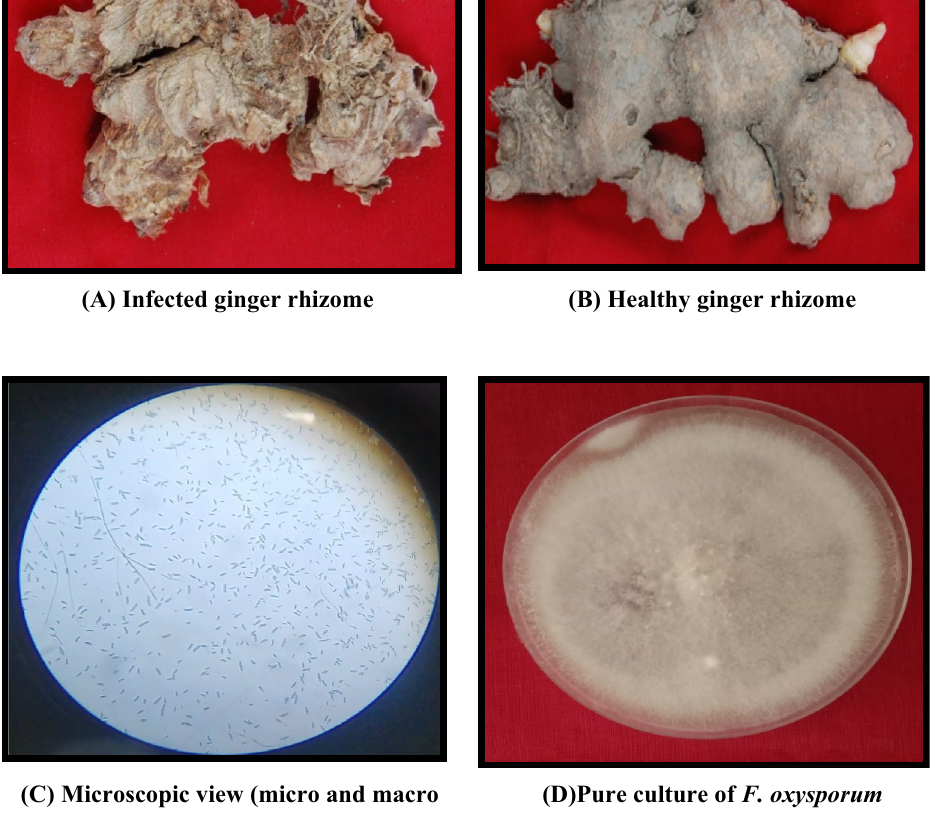
Figure 7. ( A – B ) Infected and healthy ginger and ( C – D ) Microscopic view and pure culture of dry rot of ginger ( F. oxysporum